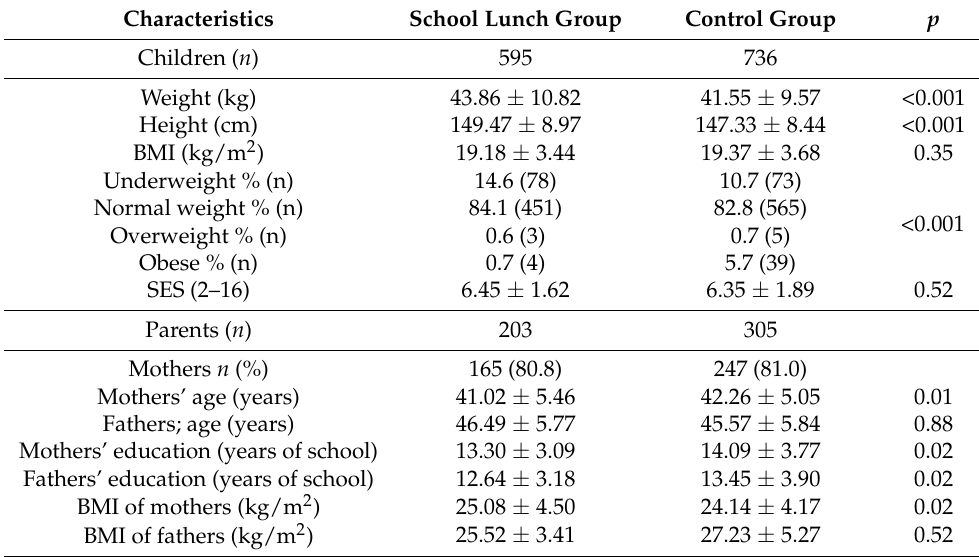
Table 1. Sociodemographic and anthropometric characteristics of children and their parents per population group. Characteristics School Lunch